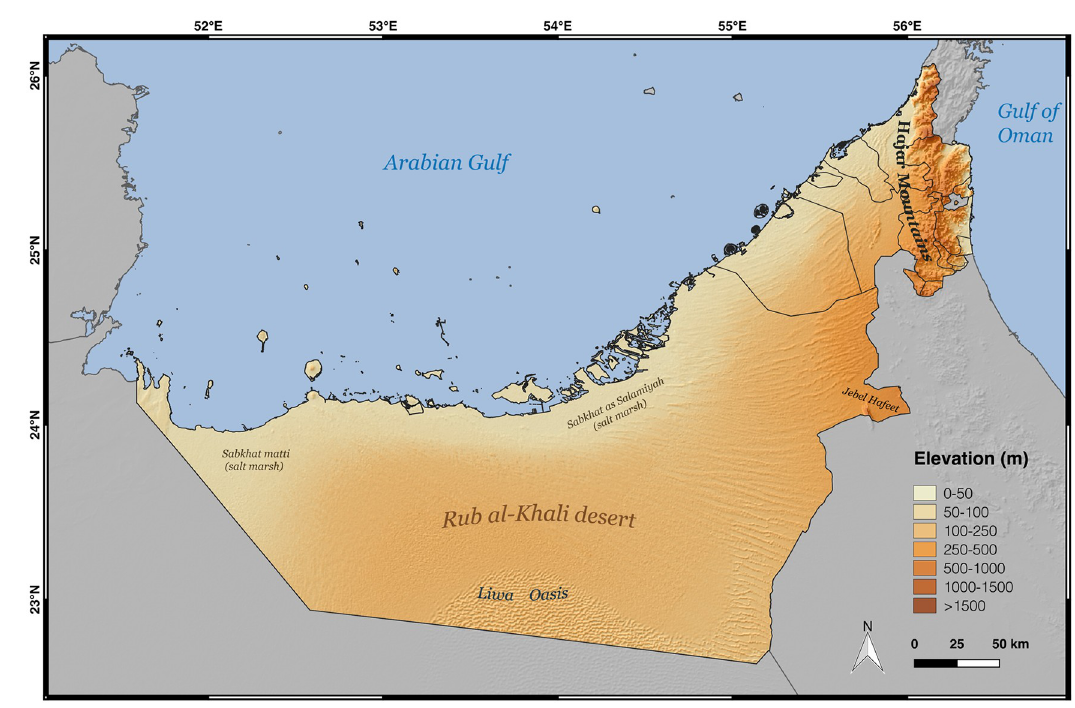
Fig 1. Physical map of the UAE. Map of the UAE showing topographical relief and names of relevant toponyms. Credits: OpenStreetMap contributors, SRTM.